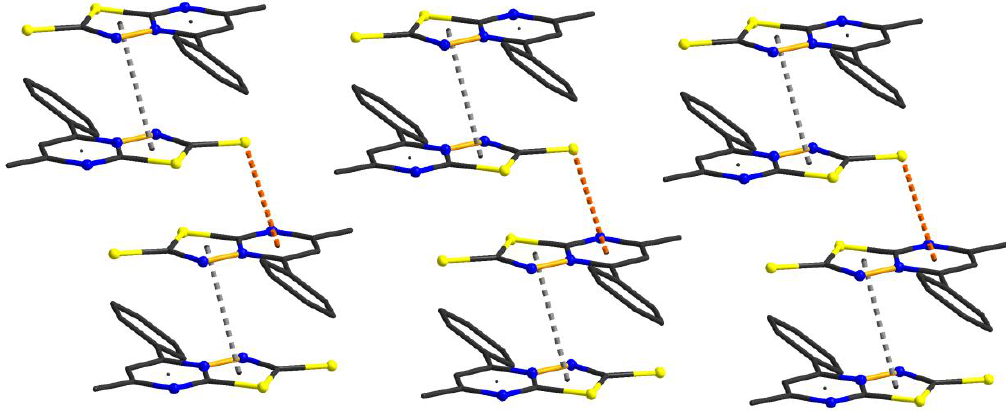
Figure 5. Supramolecular columns of ( 2 ) in the solid-state.